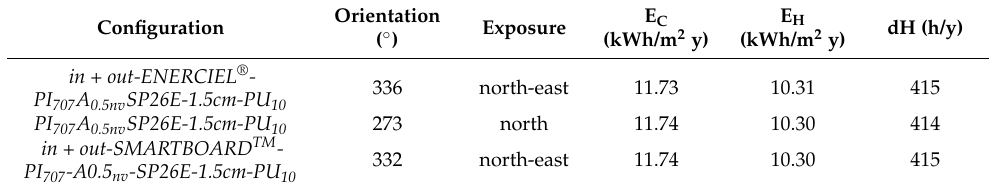
Table 6. Results of the optimal